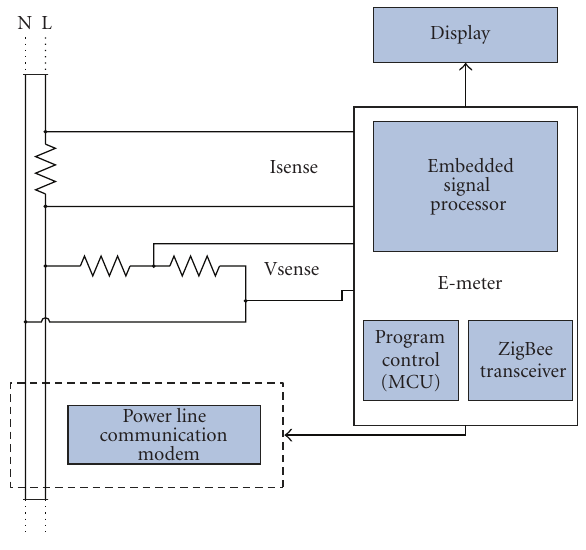
Figure 11: Architecture of the smart